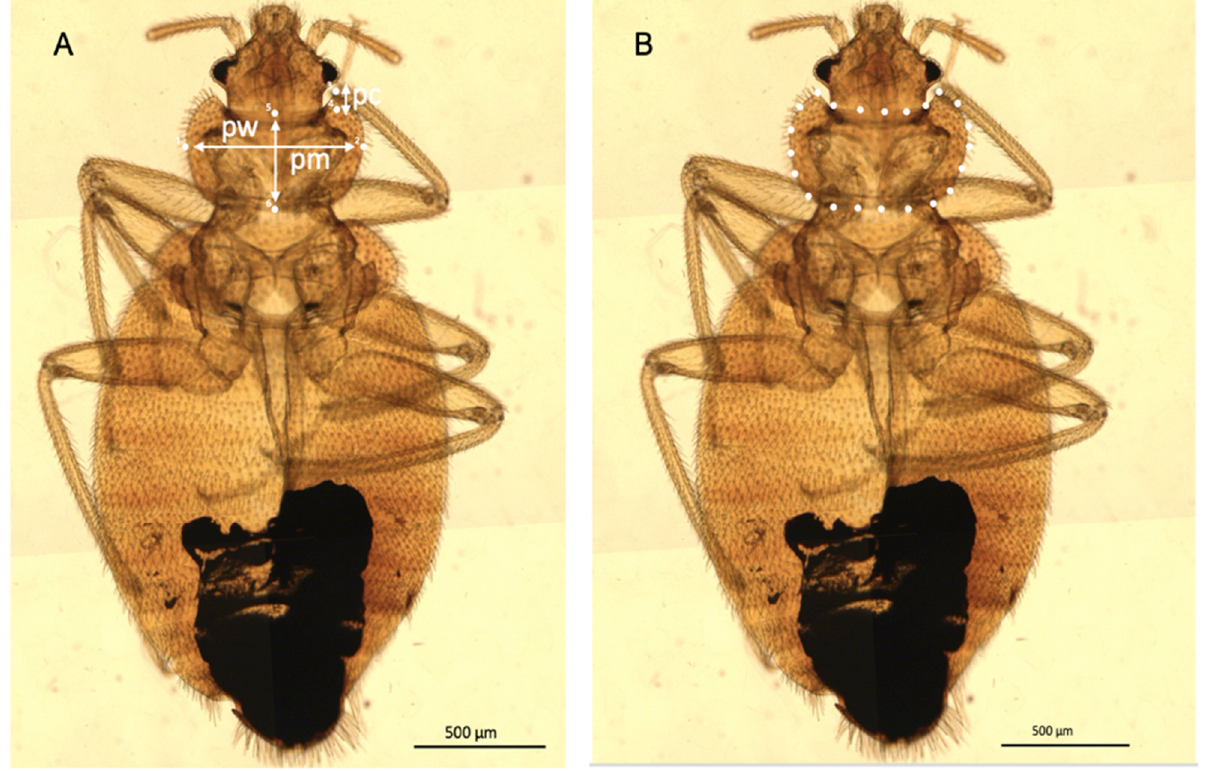
Figure 1. ( A ) Dorsal view of Cimex hemipterus male taken with the Zeiss Axio Imager M2 with the scale 0.5 mm. Illustration of the linear measurements applied to the pronotum and used as input for the linear morphometry. pw, pronotum width; pm, pronotum length (medial); pc, anterior pronotal concavity depth. ( B ) Picture illustrating the pseudolandmarks (white dots) digitized along the pronotum contour and used as input for the outline-based morphometry.